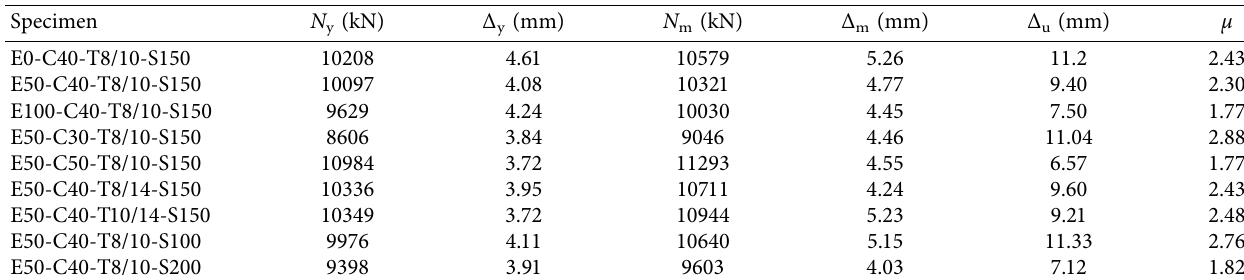
Figure 6: Axial load-displacement curves according to (a) cross-shaped steel eccentricity ratio, (b) concrete strength, (c) steel profile ratio, and (d) stirrup spacing. Table 3: Test